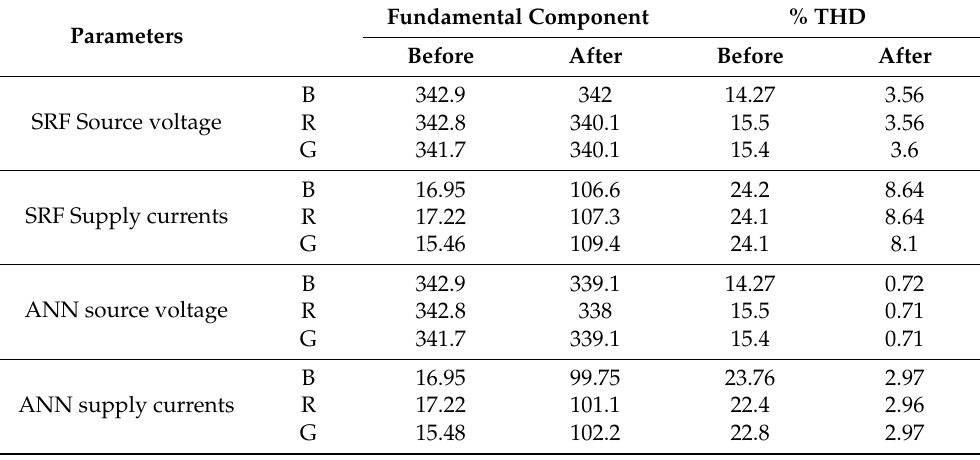
Table 2. Comparison between conventional UPQC using SRF based control and ANN controller.